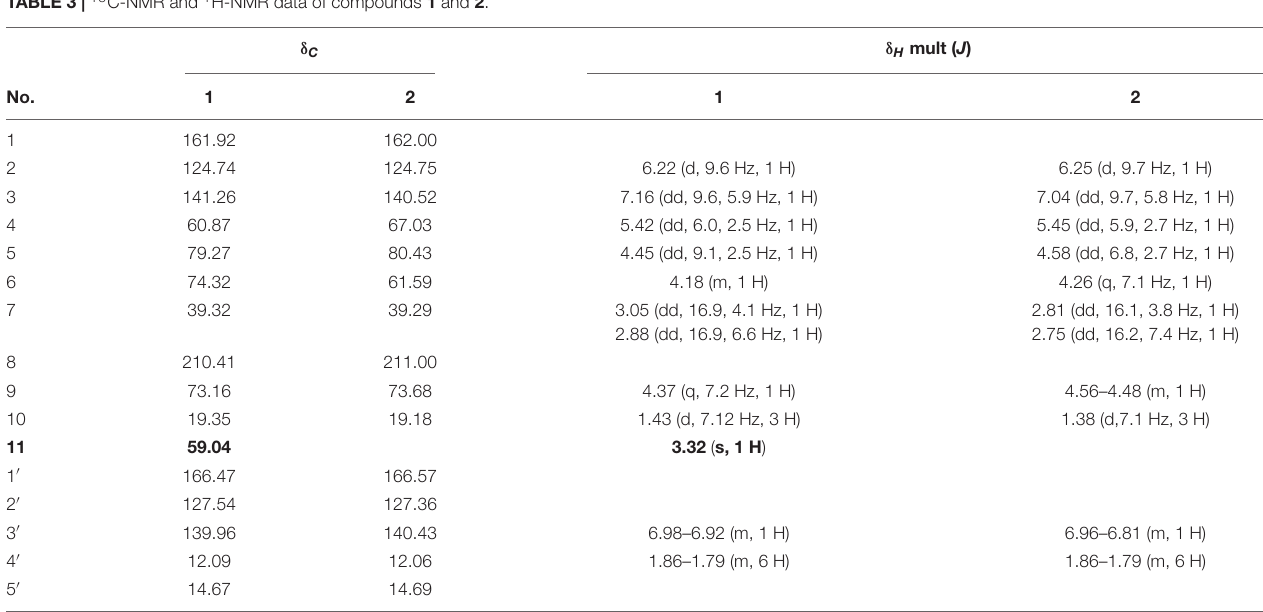
TABLE 3 | 13 C-NMR and 1 H-NMR data of compounds 1 and 2